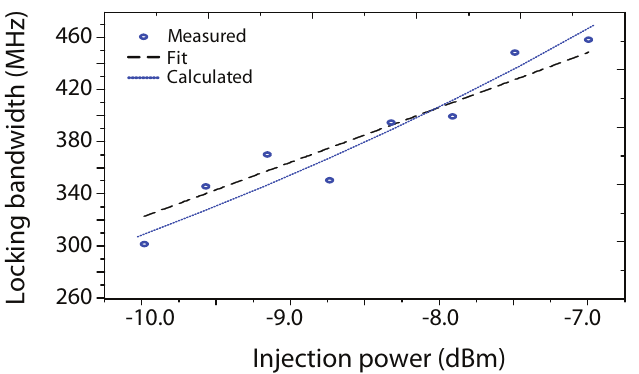
Figure 6. Experimental measurement and theoretical calculation of locking bandwidth versus injection power. The circle indicates the measured values. The dashed line indicates the theoretical fit for a Q value of 6.2 × 10 4 .